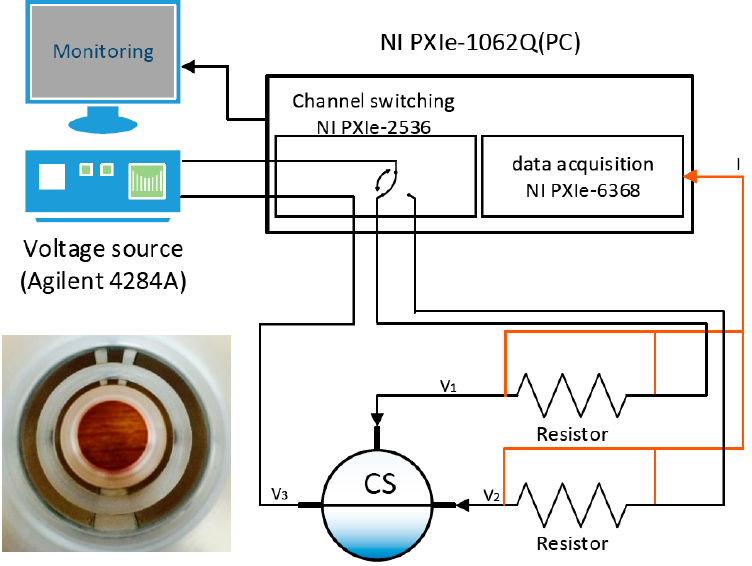
Figure 7. Measurement system for the conductance sensor. Table 4. Specifications of measurement instruments used for experiments.